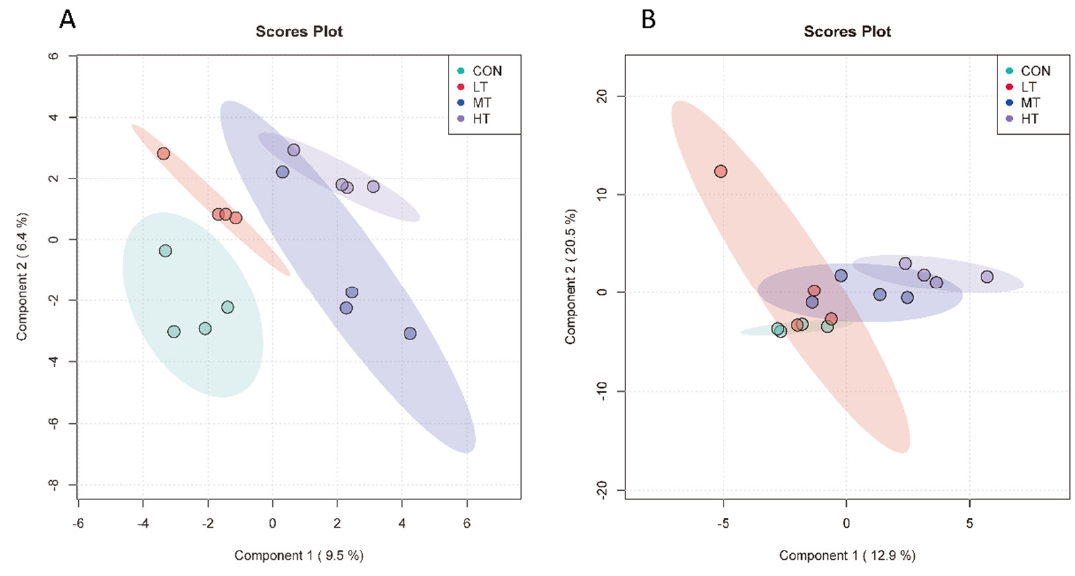
Figure 1. Partial least squares discriminant analysis of ruminal bacteria ( A ) and ruminal fungi ( B ) in different treatment groups.